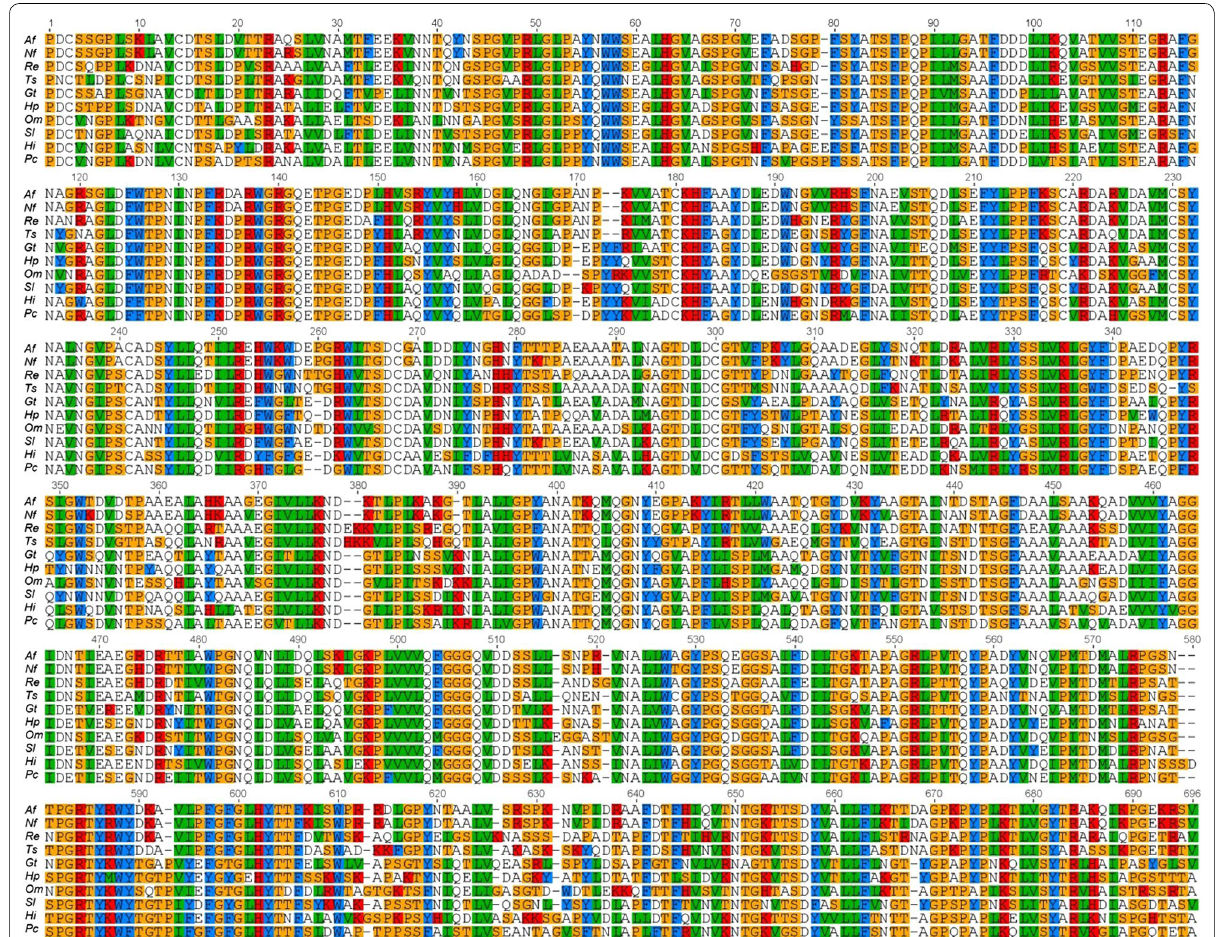
Fig. 2 Alignment of β-Xylosidase enzymes from ten fungal species. Xylosidases are from are from Aspergillus fumigatus ( Af ), Neosartorya fischeri ( Nf ), Rasamsonia emersonii ( Re ), Talaromyces stipitatus ( Ts ), Gloeophyllum trabeum ( Gt ), Hydnomerulius pinastri ( Hp ), Oidiodendron maius ( Om ), Serpula lacrymans ( Sl ), Heterobasidion irregulare ( Hi ), Phanerochaete carnosa ( Pc